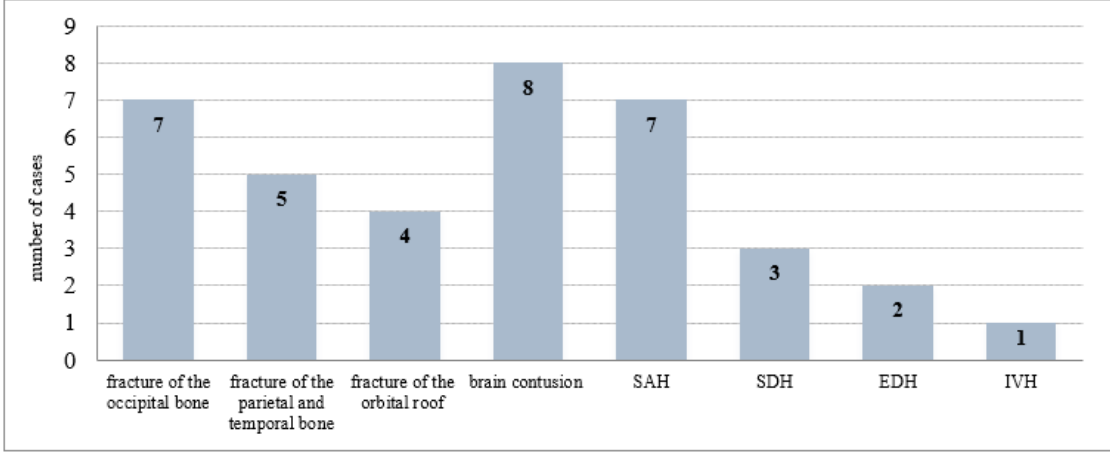
Figure 2. The false negative cases after repeated assessment of CT scans (37) for each type of injury. SAH—subarachnoid hemorrhage; SDH—subdural hemorrhage; EDH—epidural hemorrhage; IVH—intraventricular hemorrhage.